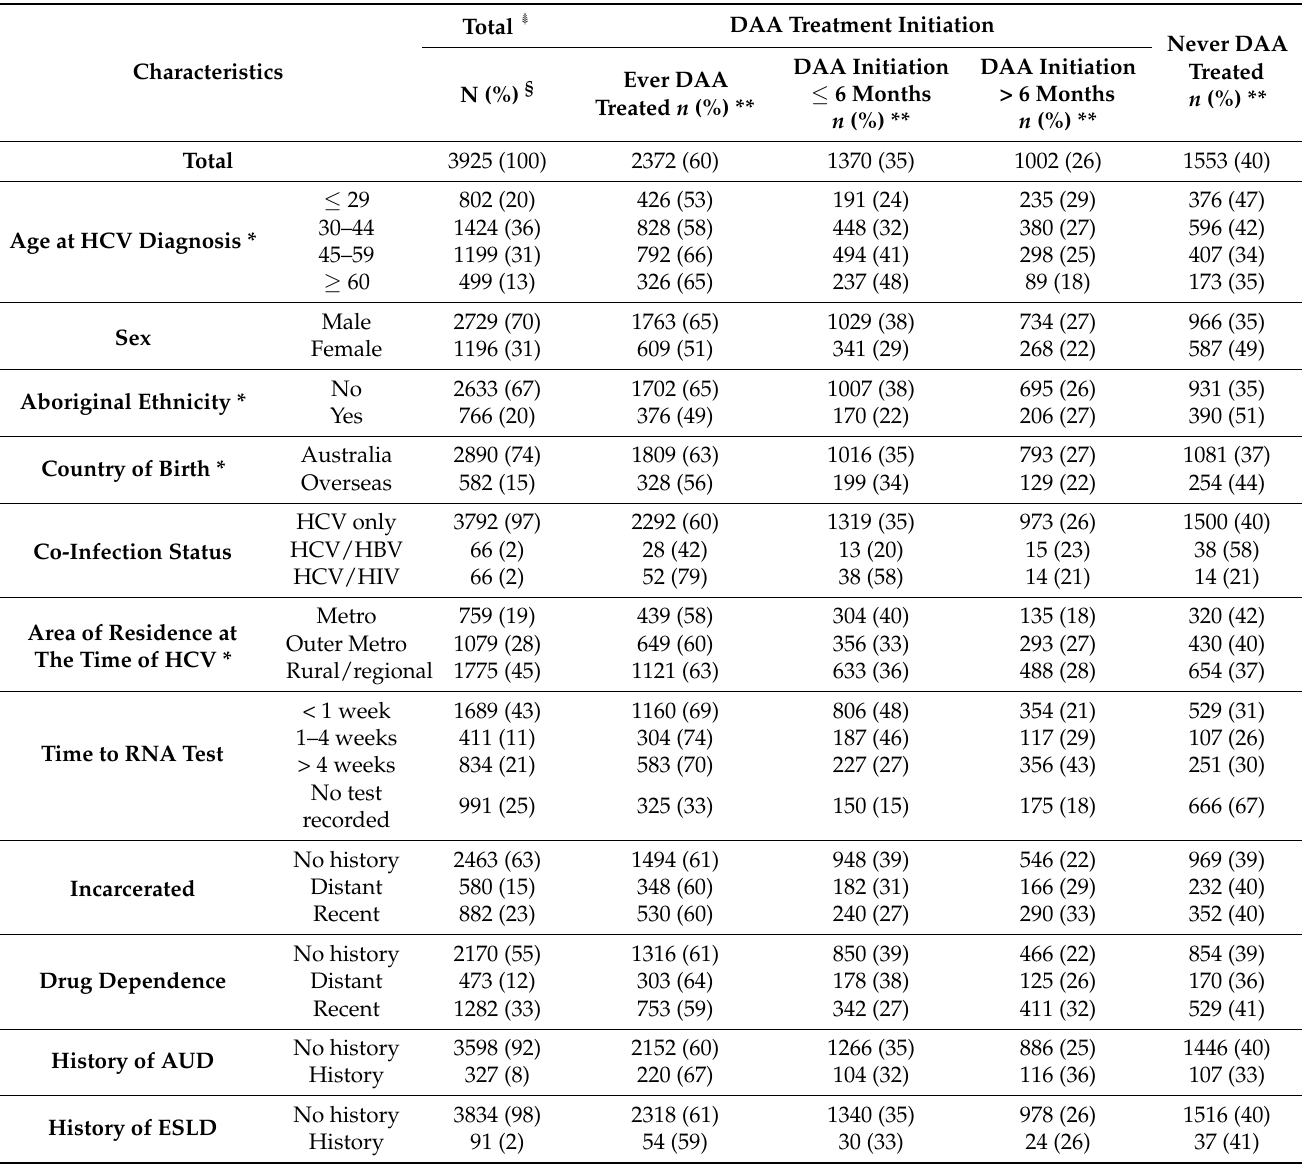
Table 2. Distribution of sociodemographic and clinical characteristics of people with an HCV notifi- cation across different periods of time to treatment initiation in NSW 2016–2018 (N = 3925).